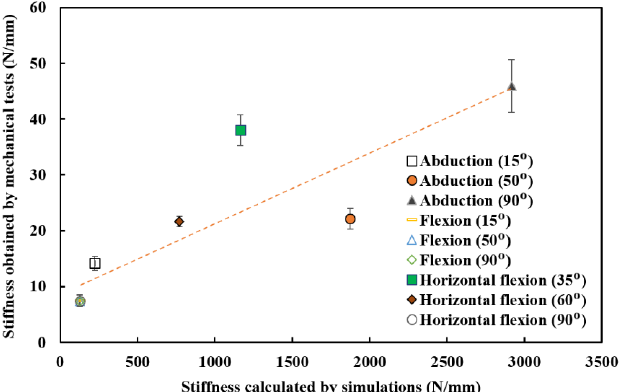
Figure 6. Correlation study between the mechanical tests and the finite element analysis.